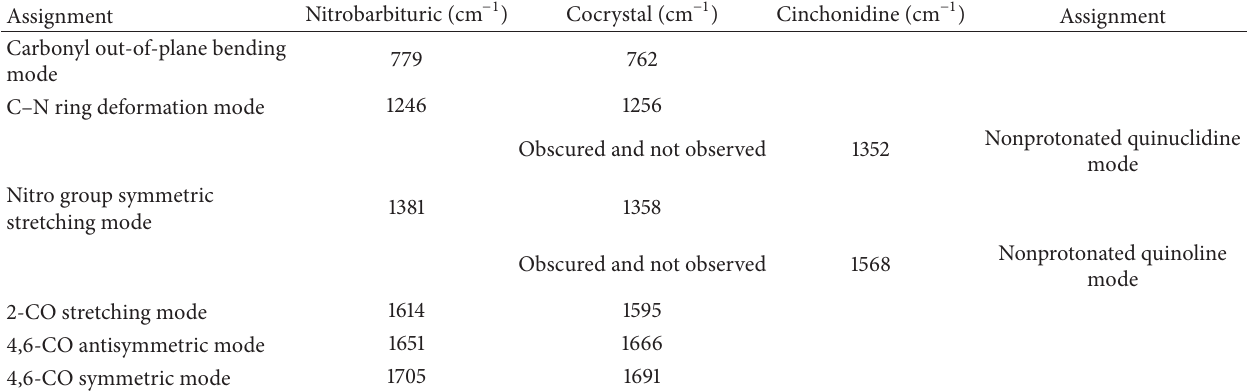
Table 3: Assignments of the major bands in the fingerprint region of the infrared absorption spectra of 5-nitrobarbituric acid, cinchonidine, and their 1:1 cocrystal